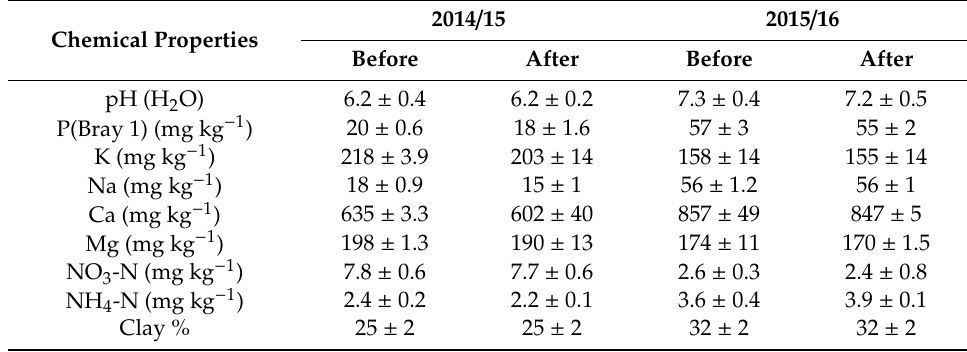
Table 1. Chemical properties of the topsoil layer (0.3m) for the experimental sites. Chemical Properties